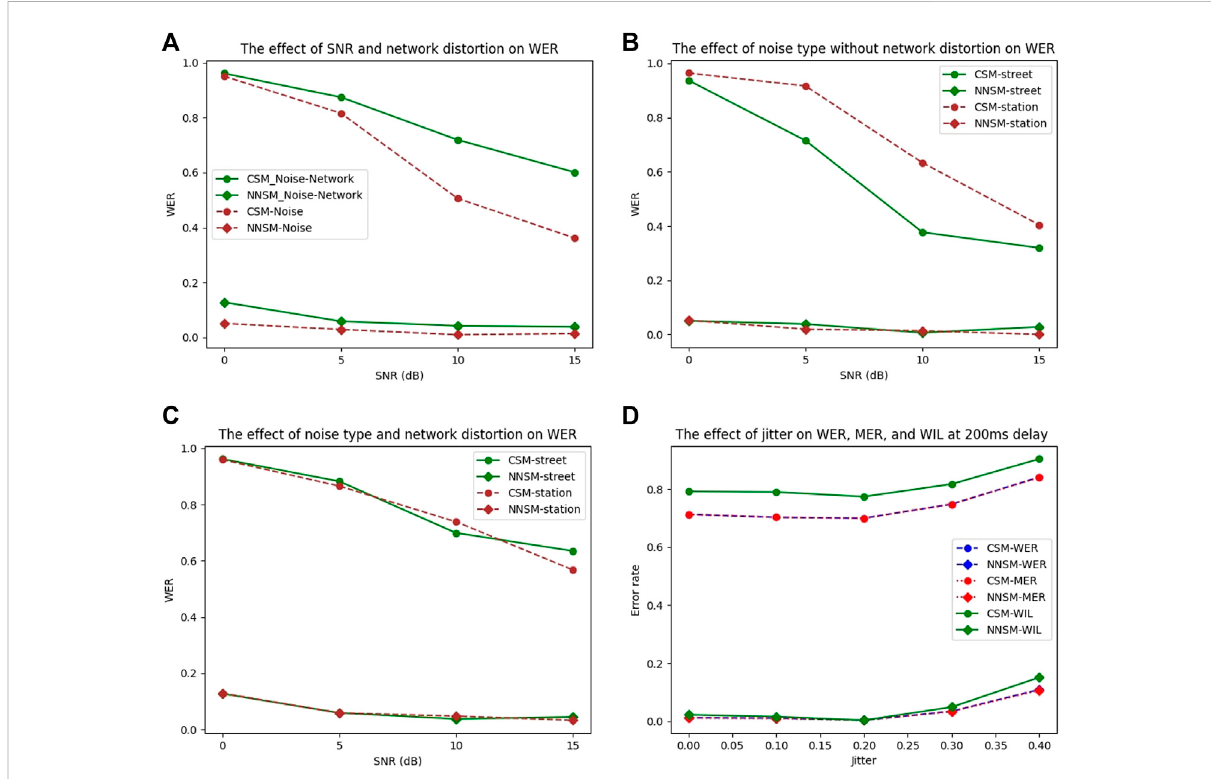
FIGURE 2 Effects of SNR, noise type, and network distortions on WER, and the effect of jitter on WER, MER and WIL. (A) Effects of SNR and network distortion on WER. (B) Effect of street noise and station noise without network distortion on WER. (C) Effects of street noise and station noise with network distortion on WER. (D) Effects of jitter on WER, MER, and WIL, for a delay of 200 ms with packet loss of